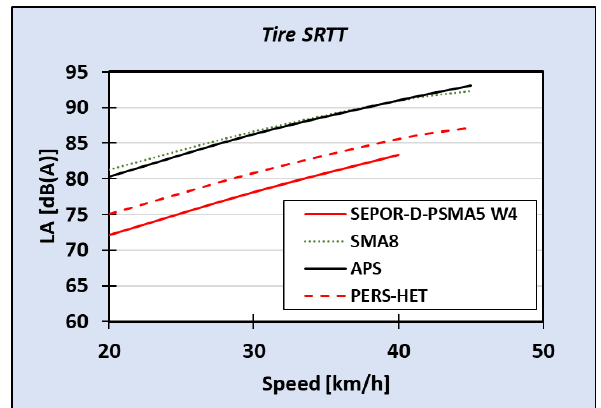
Figure 34. Roadwheel facility at GUT.